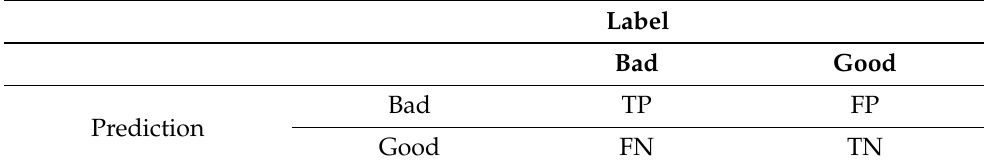
Table 3. Confusion matrix of prediction results.